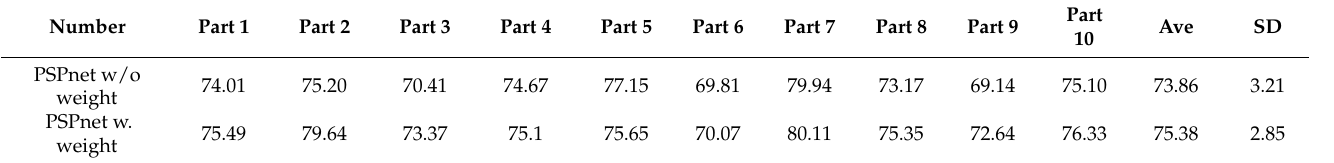
Figure 6. Dataset division when using 10-fold cross-validation. Table 3. Comparative experimental results with or without weighting.